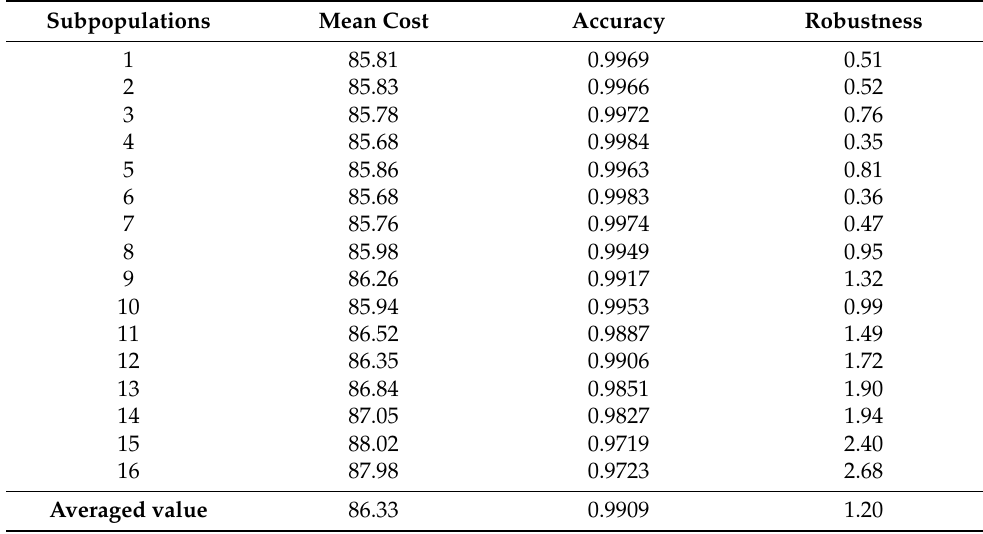
Table 2. Cross-section under flexure. Local, small, random displacement (LSRD). Performance metrics. Subpopulations Mean